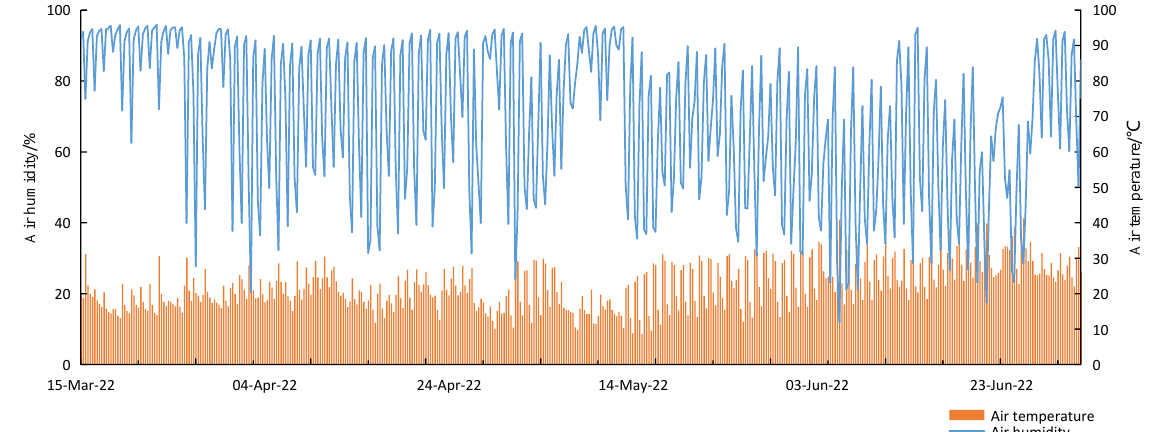
Figure 4. Air temperature and humidity in solar greenhouse.